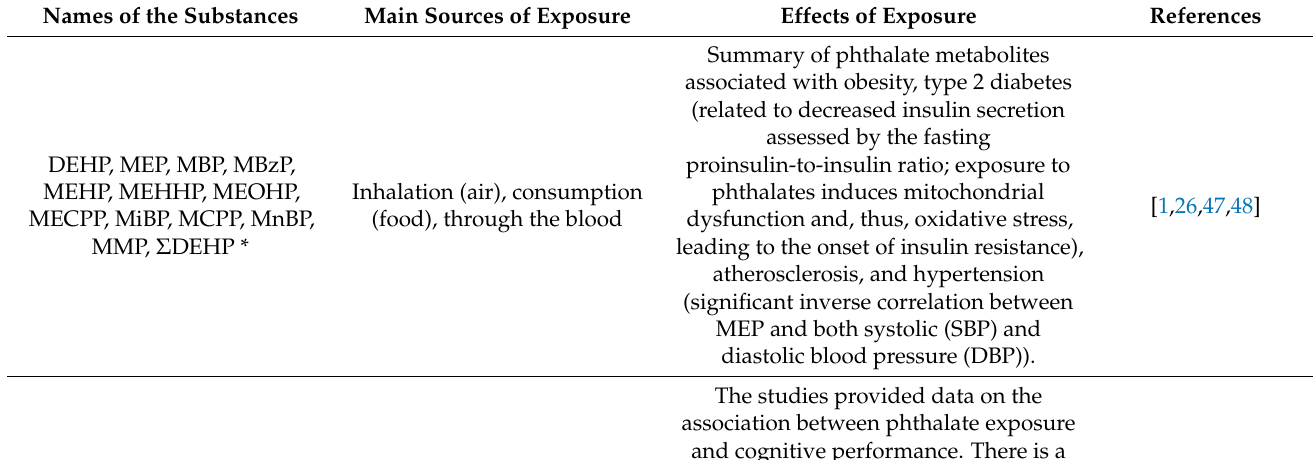
Table 4. Impacts of selected phthalates on human